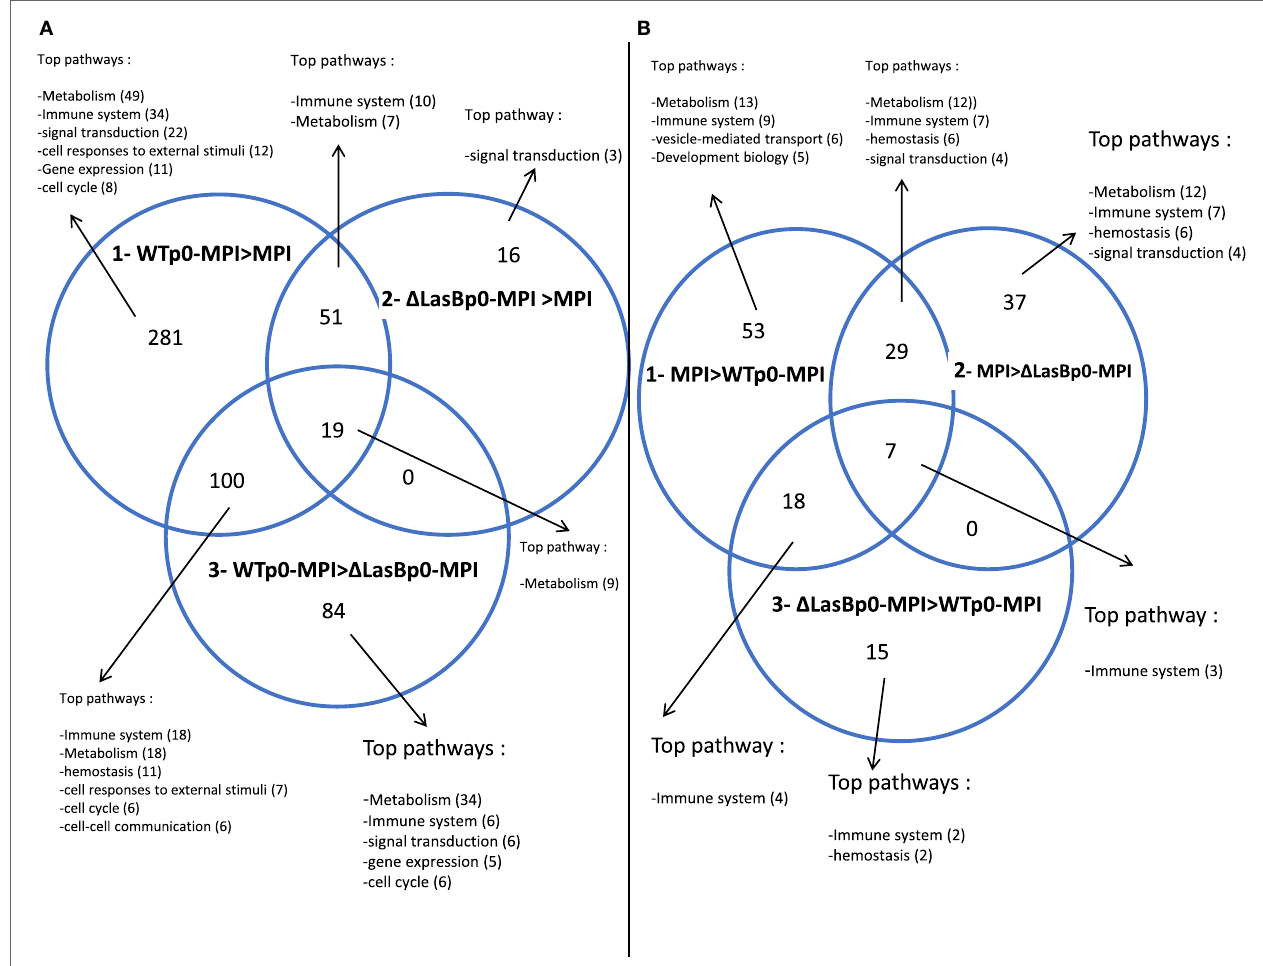
FigUre 7 | Venn diagrams of MPI hits (see Figure 6 ) whose expression differ by a factor of at least 2 ( p < 0.05) between the represented conditions (see full list in Figures S5–S10 in Supplementary Material). (a) Circle 1: WTp0-PAO1-MPI > MPI control; circle 2: Δ LasBp0-PAO1-MPI > MPI control; circle 3: